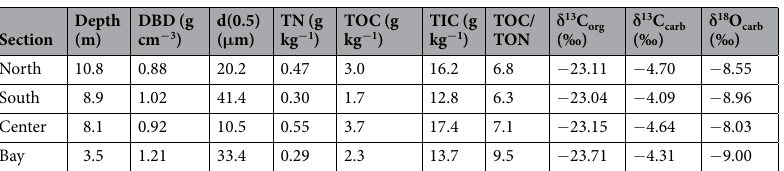
Table 2. Means of the variables in different sections. North: H7, H8, H13, H14; South: H6, H10, H11; Center: H3, H9,H15; Bay: H4, H5, H26.